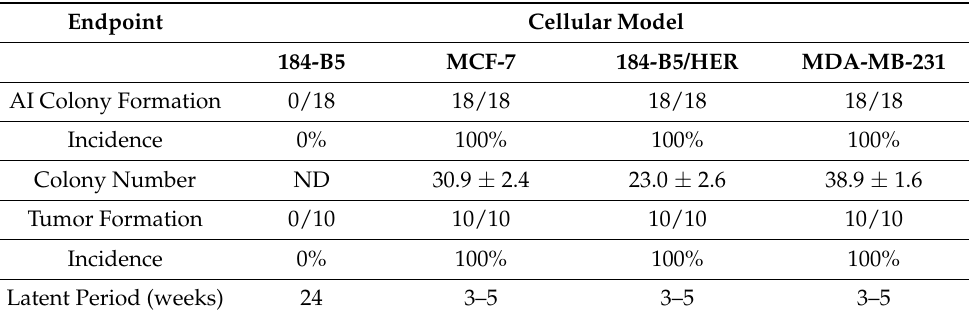
Table 2. Growth characteristics of cellular models for breast cancer.